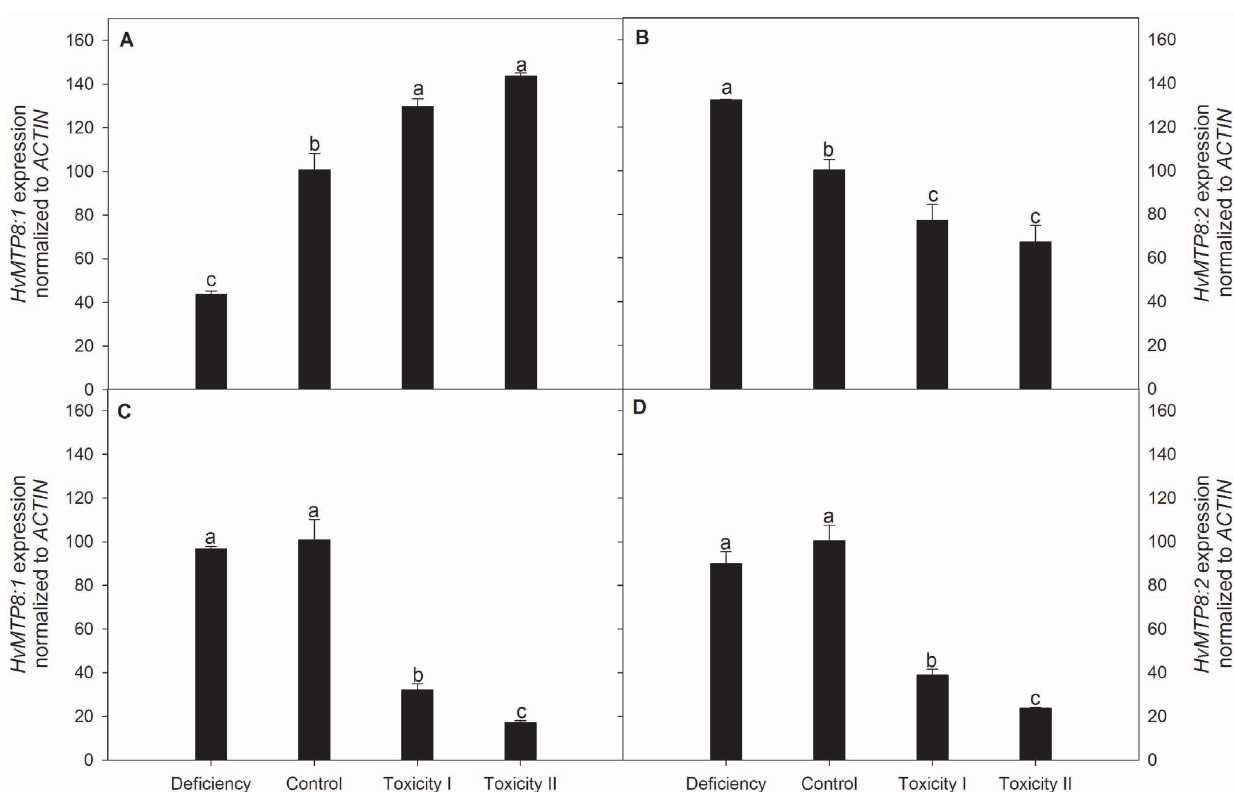
Fig. 6. Quantitative expression analysis of MTP8 genes in barley plants grown with insufficient, control or two increasing Mn toxicity levels. The expression level of MTP8.1 (A and C) and MTP8.2 (B and D) were determined in root (A and B) and shoot tissue (C and D). Data are normalized with respect to the expression of the reference gene ACTIN . Furthermore the relative changes in MTP8 expression levels are indexed to barley plants grown under control conditions. Data represent means (n 5 3) ¡ SE. Values with the same letter between treatments for each MTP gene and plant organ are not significantly different (P .